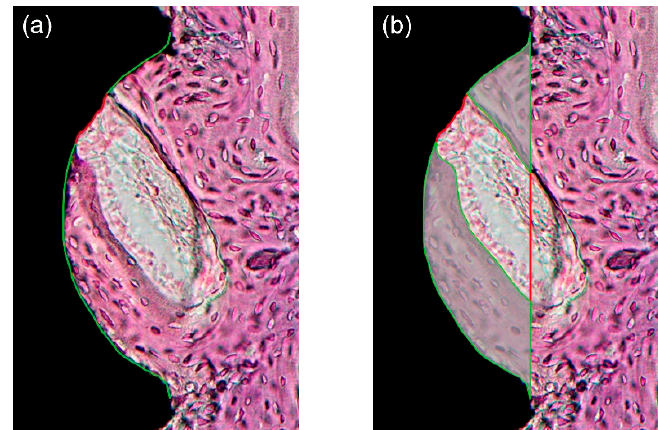
Figure 4. ( a ) Bone-to-implant contact (BIC, %) calculated by the length of the green lines divided by the total length of the well (green and red lines); ( b ) Bone area (BA) calculated by the area marked with green lines divided by the total area of the well. Note that the region-of-interest (ROI) was defined as an area within the three best consecutive threads engaged in the upper cortical bone, and therefore, a total of three threads were used for the calculation. Only one third of ROI is shown for simplicity.